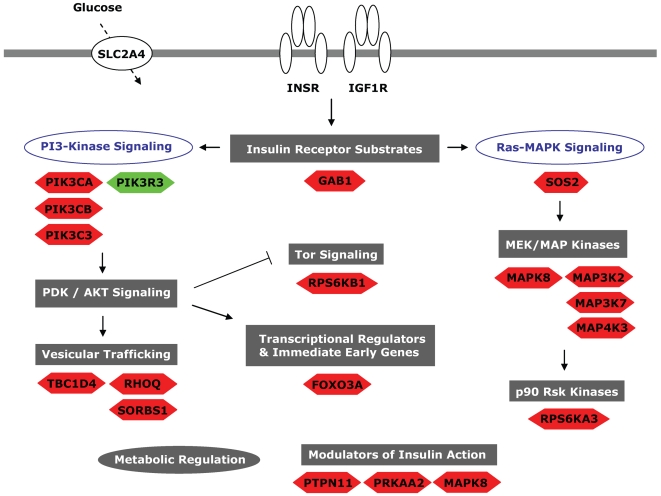
Regulation of insulin signaling in first degree relatives of people with type 2 diabetes.The insulin signaling pathways were found to be significantly upregulated on the gene expression level using the program GenMAPP/MAPPFinder. Analysis criteria were set as described in the Methods section. Underneath each section of the pathway, genes found to have an increased expression are depicted in red, and genes found to have a decreased expression are depicted in green. Figure adapted from GenMAPP.